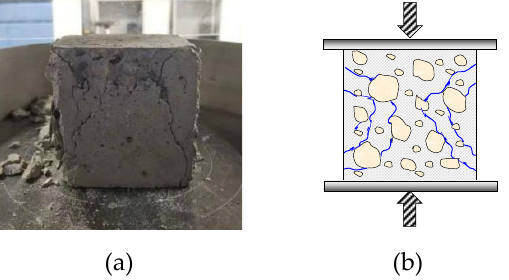
Figure 8. Failure pattern of C1. ( a ) appearance; ( b ) crack propagation.